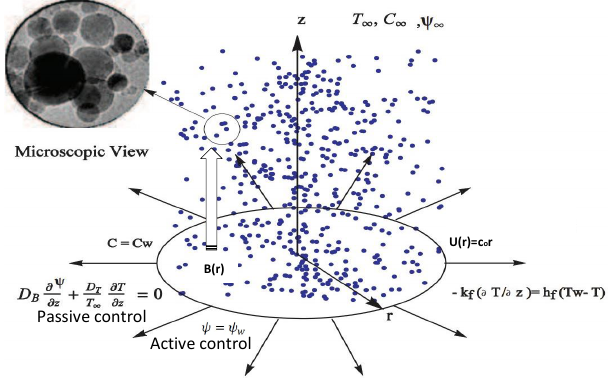
Figure 1. Physical configuration and coordinate